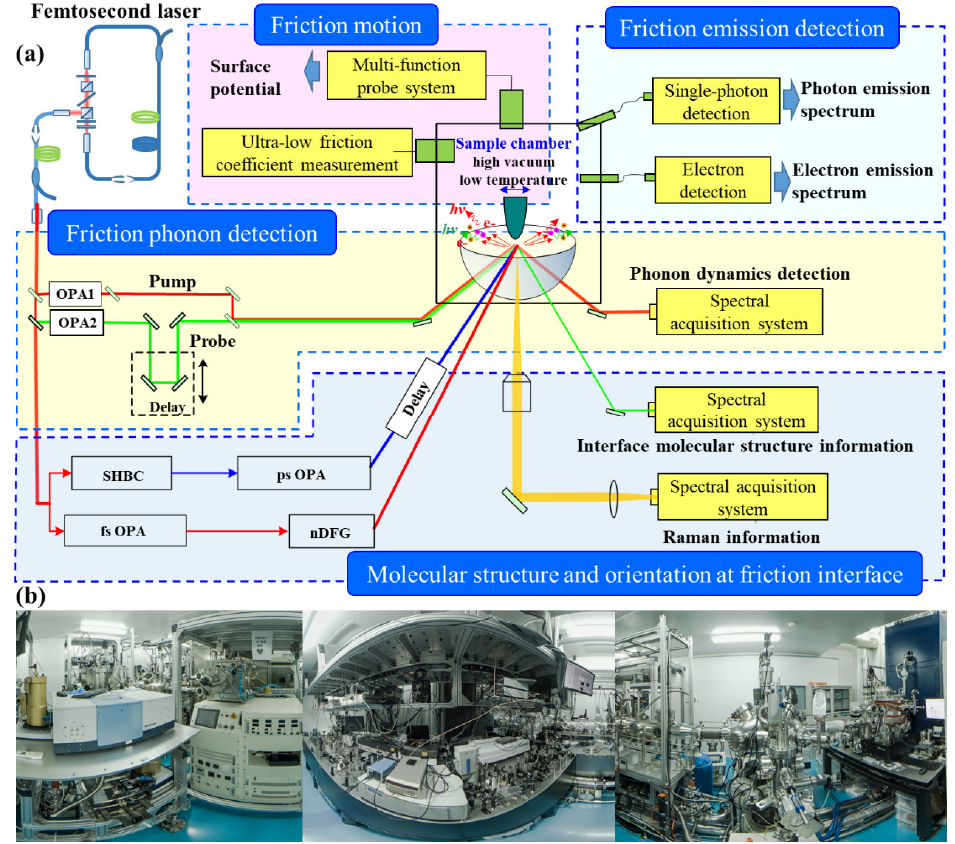
Fig. 11 (a) Schematic and (b) partial physical mappings of the high-resolution friction energy dissipation detection system. Reproduced with permission from Ref. [6] for (a), © Science China Press